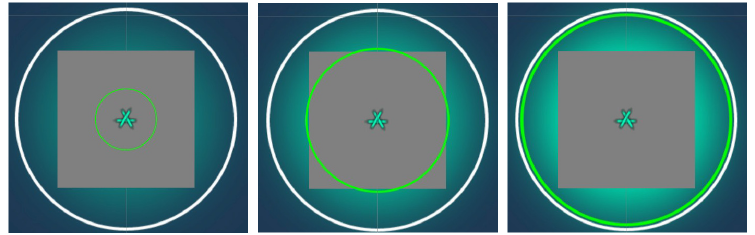
Figure 8. The green circle grows; the selection is activated when the green circle radius is the same as that of the white